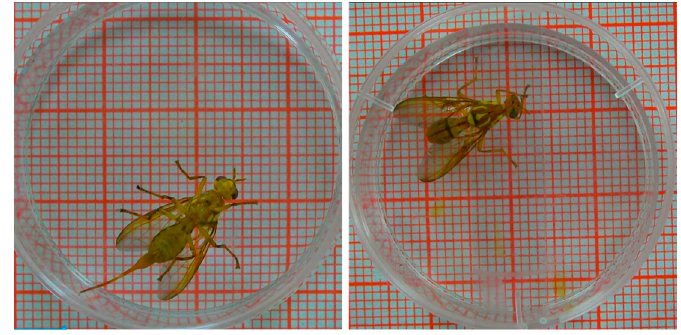
Figure 2. The original video frames of Bactrocera minax. The original video was cut, only the middle